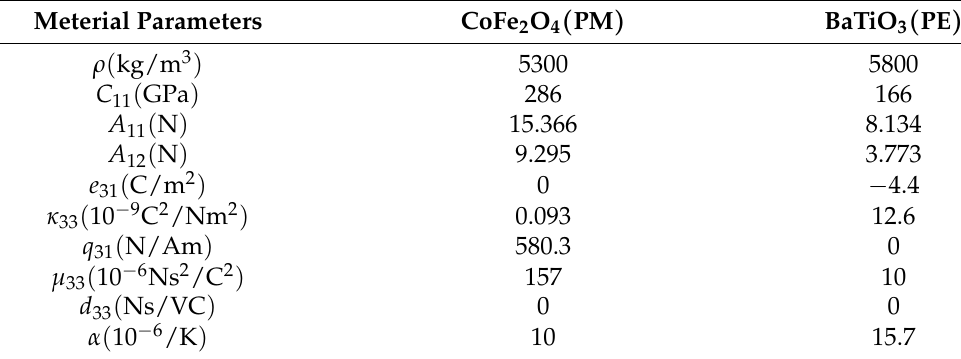
Table 1. Parameters of CoFe 2 O 4 and BaTiO 3